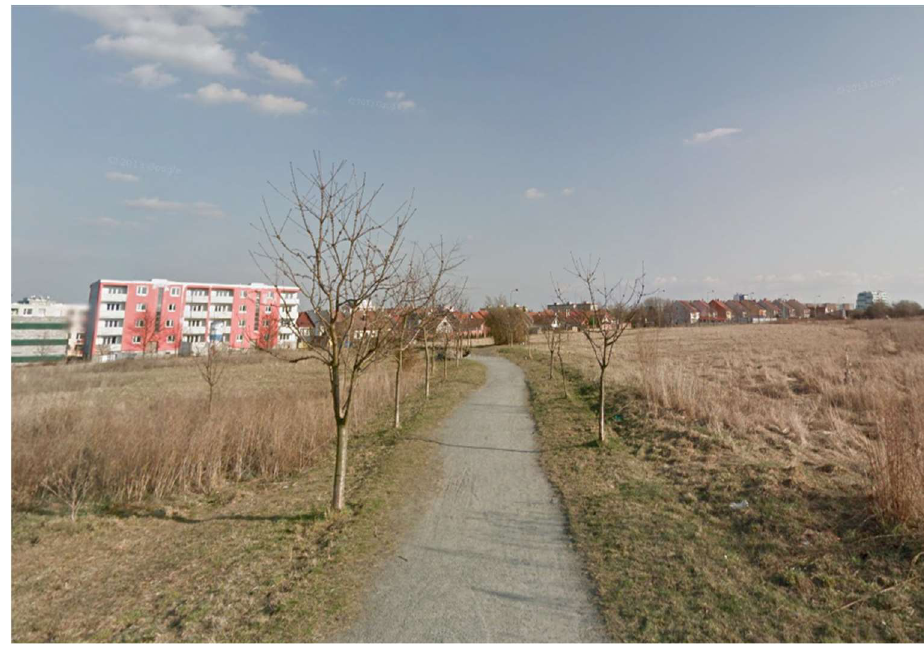
Figure 4. The open space environment.